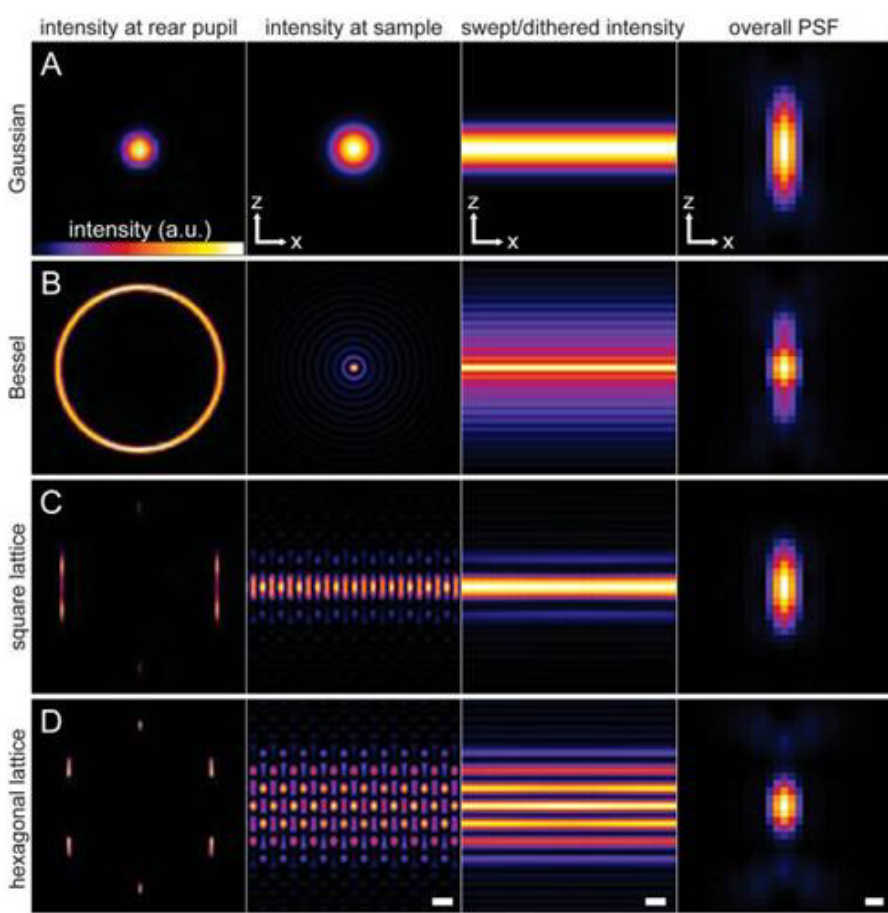
Figure 6. Methods of light sheet microscopy. ( a ) The traditional approach, in which a Gaussian beam is swept across a plane to create the light sheet. ( b ) A Bessel beam of comparable length produces a swept sheet with a much narrower core but flanked by sidebands arising from concentric side lobes of the beam. ( c , d ) Bound optical lattices create periodic patterns of high-modulation depth across the plane, greatly reducing the peak intensity and the photo-toxicity in live-cell imaging. The square lattice in ( c ) optimizes the confinement of the excitation to the central plane, and the hexagonal lattice in ( d ) optimizes the axial resolution as defined by the overall point spread function (PSF) of the microscope. The columns in ( a to d ) show the intensity pattern at the rear pupil plane of the excitation objective; the cross-sectional intensity of the pattern in the xz plane at the focus of the excitation objective (scale bar = 1.0 μm); the cross-sectional intensity of the light sheet created by dithering the focal pattern along the x axis (scale bar = 1.0 μm); and the xz cross-section of the overall PSF of the microscope (scale bar = 200 nm). Taken from 69. Abbreviations:AU; arbitrary